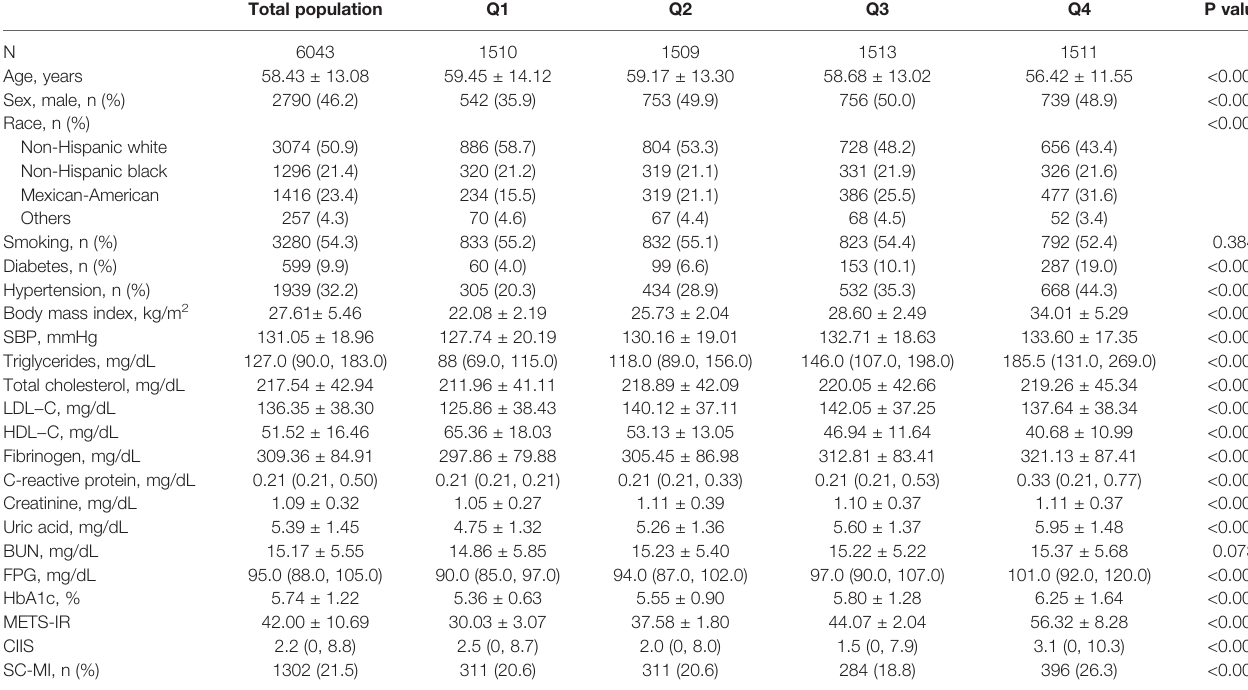
TABLE 1 | Baseline characteristics of participants strati fi ed by the quartile of the METS ‐ IR. Total